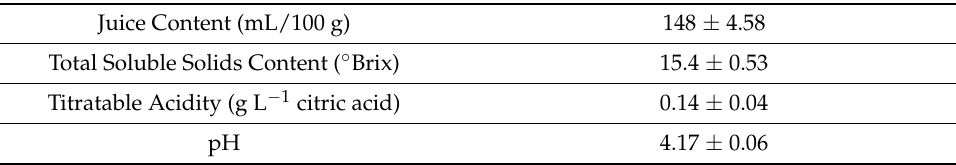
Table 3. Physico-chemical characteristics of the juice extracted from the arils prior to treatment and storage. Values are expressed as mean ± standard deviation (n =